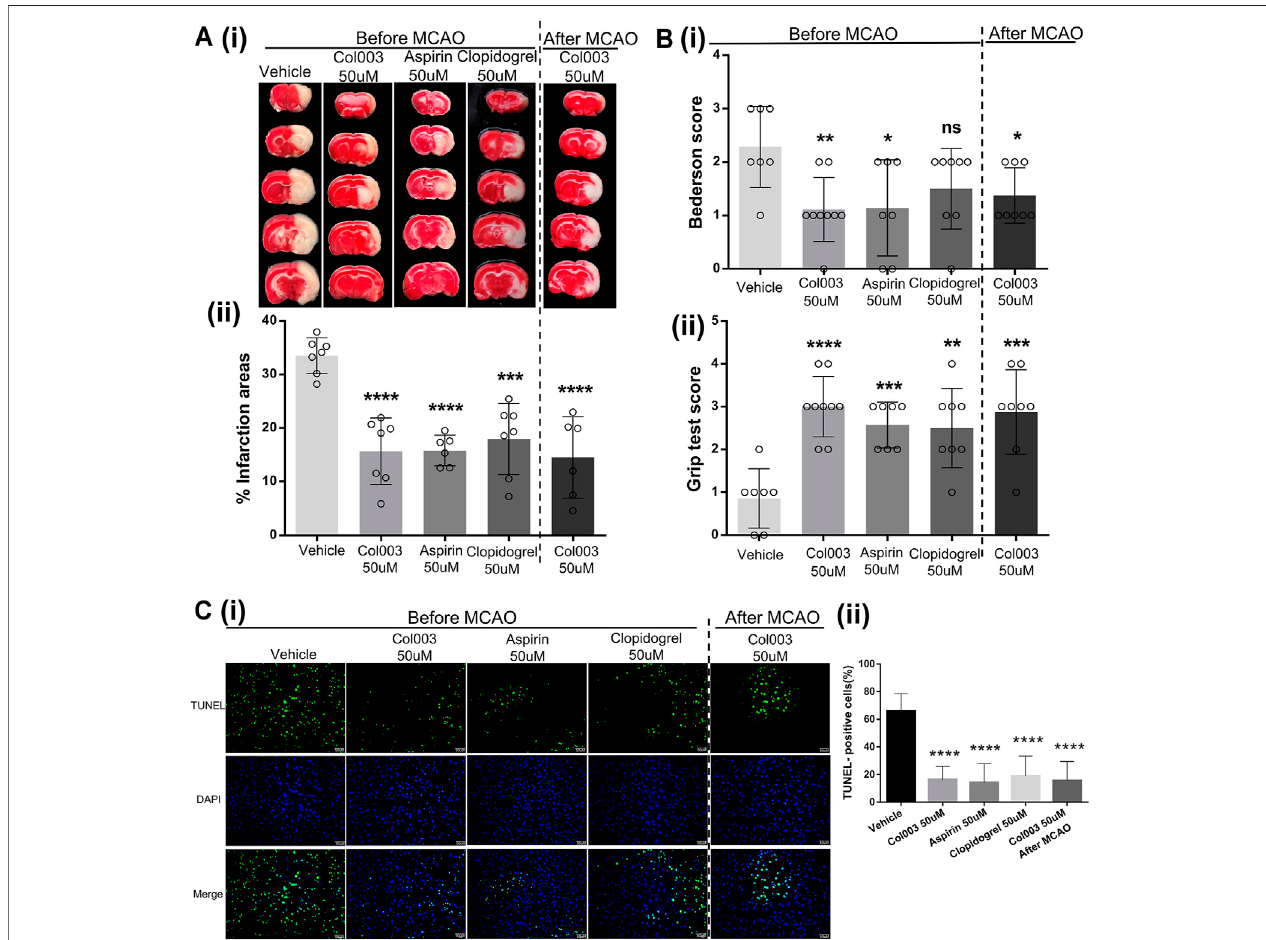
FIGURE 5 | The cerebral infarct volume and outcome of rats after MCAO. (Ai) Representative brain sections stained with TTC. Healthy tissue appeared red, whereasinfarct areas stainedwhite. (Aii) Brain infarct volumes ofdifferentgroupswerequanti fi edbyplanimetric analysis.Theinfarctionareas (%)inthe fi vegroupswere 33.52 ± 1.26%(Vehicle),15.66 ± 2.34%(Col00350uMbefore),15.81 ± 1.17%(Aspirin50uMbefore),17.95 ± 2.52%(Clopidogrel50uMbefore),14.53 ± 3.09%(Col003 50uM after), respectively. (Bi) Bederson ’ s test was used to access neurological outcome. The Bederson ’ s score in the fi ve groups were 2.29 ± 0.29 points (Vehicle), 1.11 ± 0.20 points (Col003 50uM before), 1.14 ± 0.34 points (Aspirin 50uM before), 1.50 ± 0.27 points (Clopidogrel 50uM before), 1.38 ± 0.18 points (Col003 50uMafter),respectively. (Bii) Gripstrength testwasusedtoexaminethemotorfunction.Thegripscoreinthe fi vegroupswere0.86 ± 0.26points(Vehicle),3.00 ± 0.24 points (Col003 50uM before), 2.57 ± 0.20 points (Aspirin 50uM before), 2.50 ± 0.33 points (Clopidogrel 50uM before), 2.88 ± 0.35 points (Col003 50uM after), respectively. n (cid:1) 7 – 9; * p < 0.05, ** p < 0.01, *** p < 0.001, and **** p < 0.0001 (vs vehicle group). (Ci) Representative micrographs ofTUNEL staining. (Cii) Quantitation of TUNEL-positive neurons. The TUNEL-positive cells (%) in the fi ve groups were 65.80 ± 3.51% (Vehicle), 16.39 ± 2.76% (Col003 50uM before), 14.21 ± 4.32%